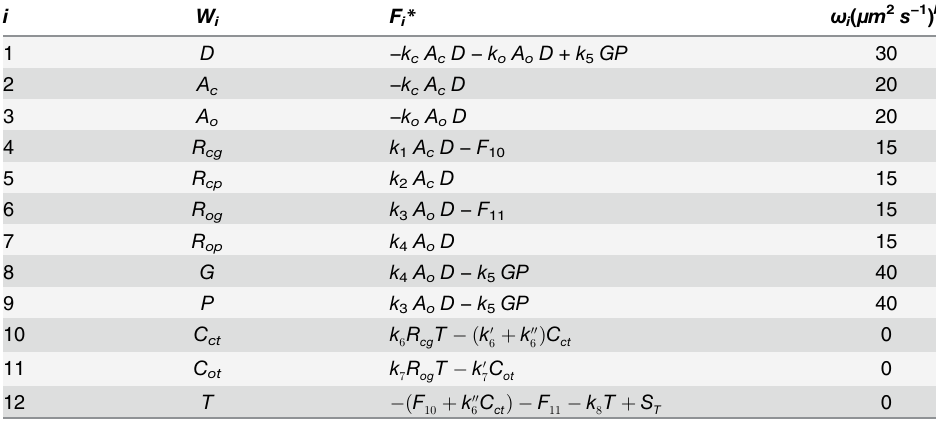
Table 1. Symbols and diffusion coefficients in Eq